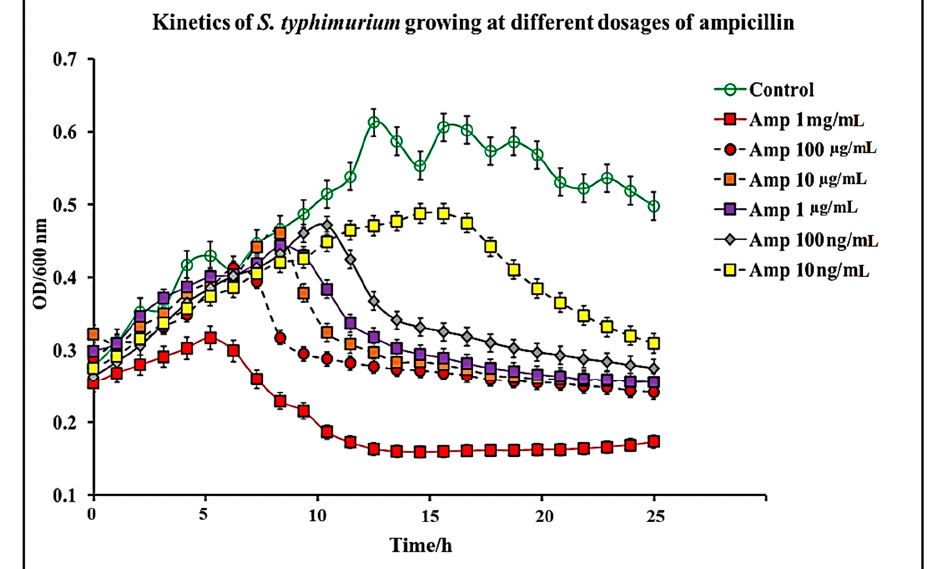
Figure 3. Kinetics of S. typhimurium growth at varying dosages of ampicillin. The results represent a mean of three independent experiments ± standard deviation.